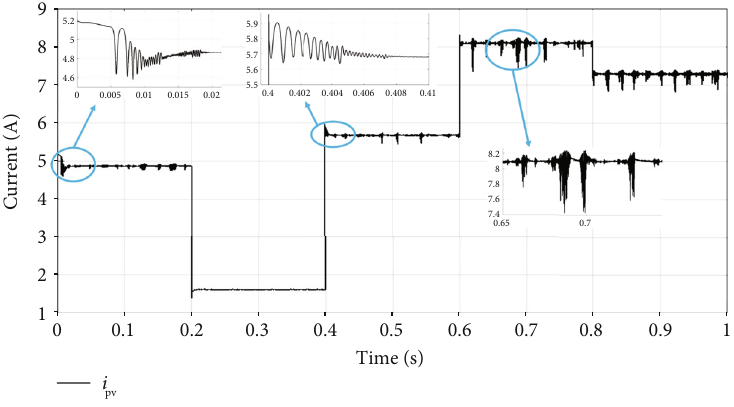
Figure 14: PV array current.